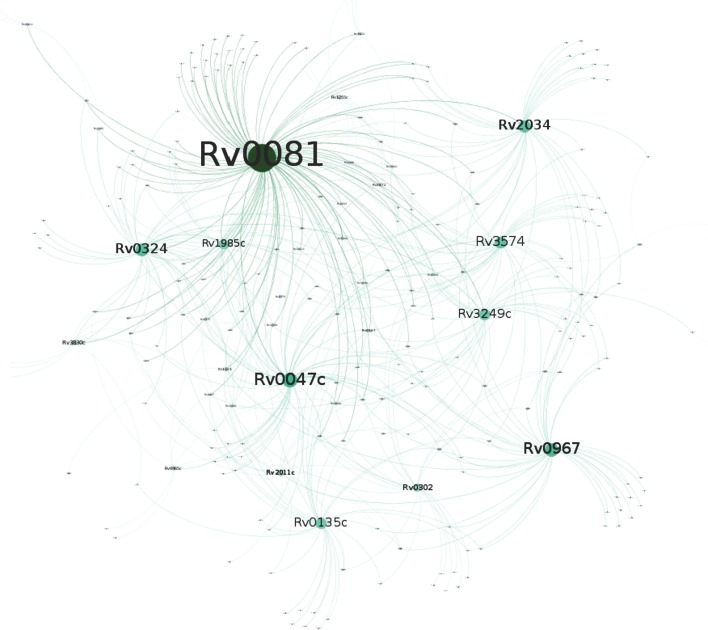
The hub of hypoxia in dextrose. The network represents genes over-expressed in DNRP1 vs. DE that interact with these TF according to the Minch's data (2015). The size of the circles is related with the number of genes controlled by the respective TF.